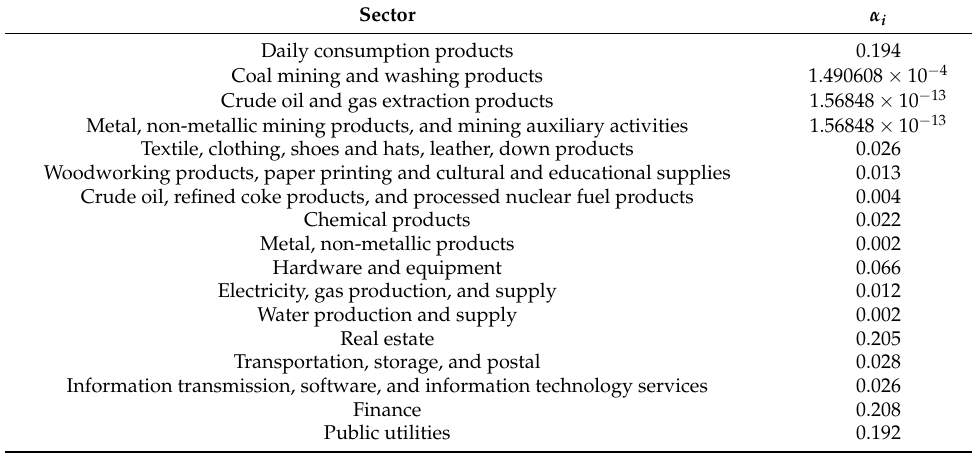
Table A2. The results of calibration of α i